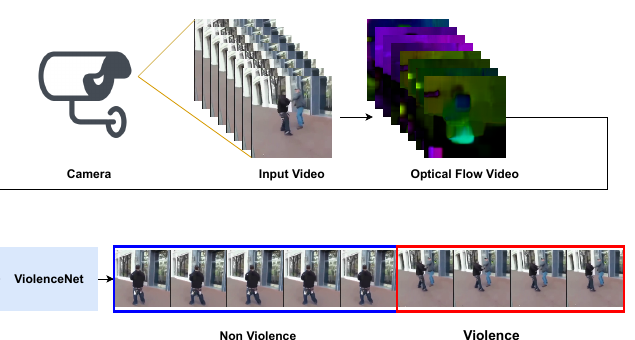
Figure 3. CCTV scheme for detection of violence scenes. In a CCTV system, our model receives the optical flow of the fragments provided by a camera and classifies each of them. The red box represents violent segments and the blue box represents non-violent